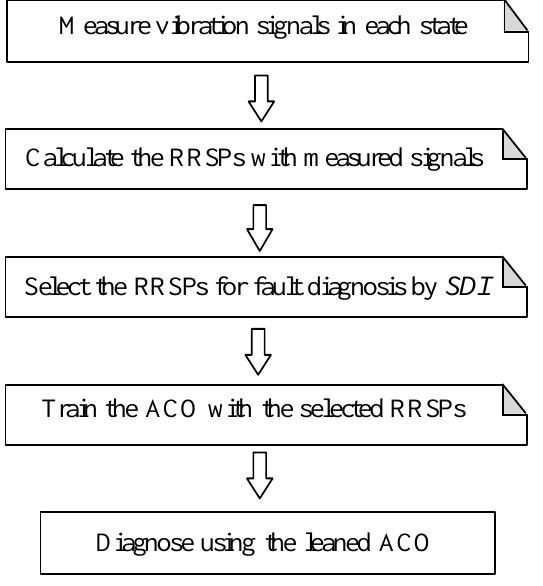
Figure 1. Flowchart of the condition diagnosis. Measure vibration signals in each state